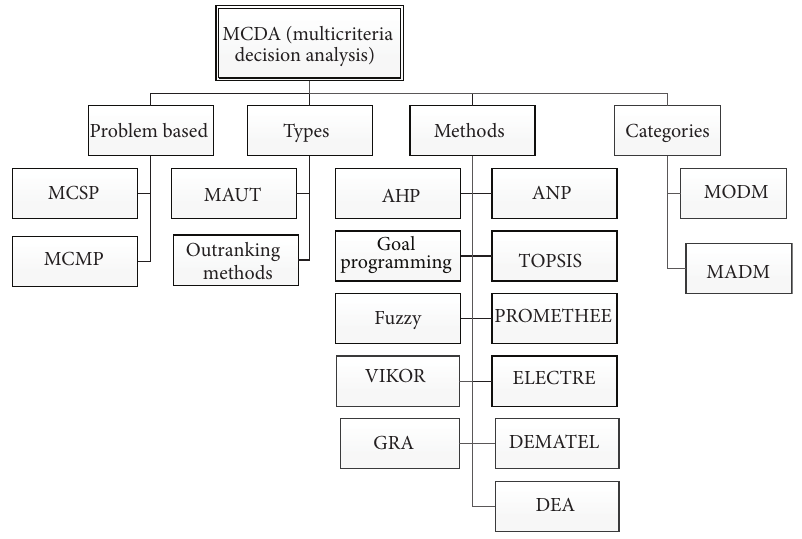
Figure 1: Taxonomy of